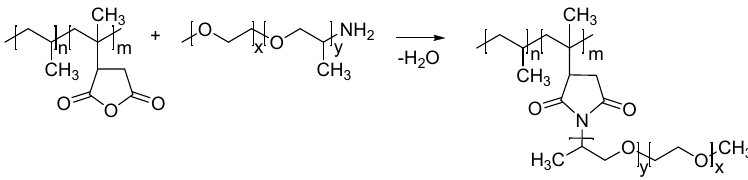
Figure 2. Reaction scheme of the reactive extrusion of PP-g-MA with P(EO-co-PO)-NH 2 .